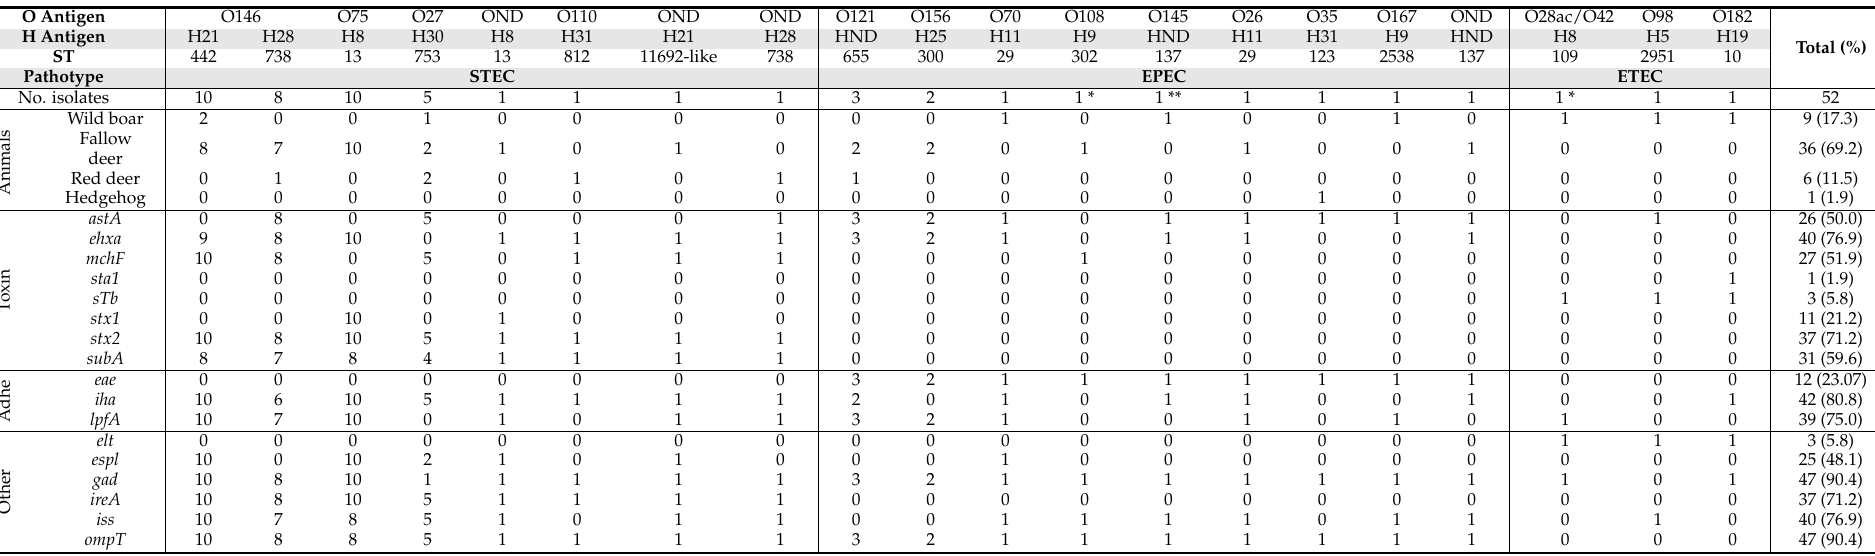
Table 2. Distribution of serotypes, sequence types, pathotypes and virulence determinants among the 52 pathogenic E. coli isolates, determined by PCR and